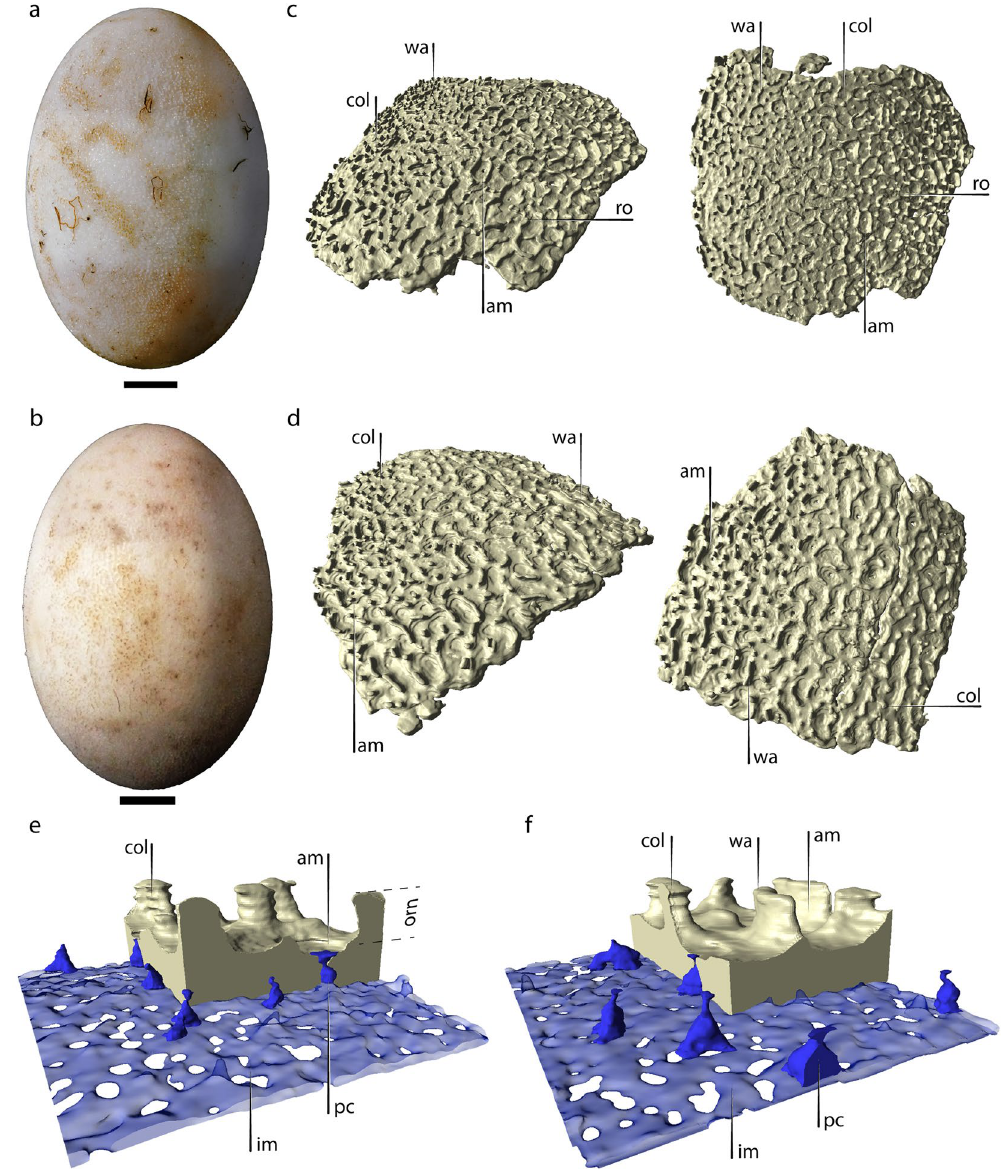
Figure 3. Eggs and eggshells of C. yacare . ( a ) Egg MLP.R.6800-39, CY2 (stage 18). ( b ) Egg MLP.R.6800-66, CY6 (stage 23). ( c ) Eggshells of CY2 and ( d ) CY6. ( e ) Detail of the eggshell of CY2 and ( f ) CY6, including pore canals and inner space plus inner shell membrane. Note that all blue-colored structures represent empty spaces. The space reconstructed in transparent blue corresponds to the inner shell membrane plus the space between the latter and the inner shell surface. am amphitheater, col vertical columns, im inner shell membrane, orn ornamentation, pc pore canal, ro roof, wa wall. Scale bars in ( a ) and ( b ) equal 10